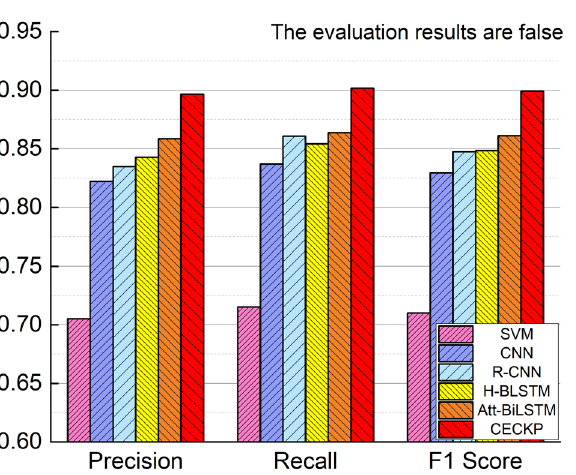
Figure 4. Performance comparison of models on the CECKP-dataset when evaluation results are